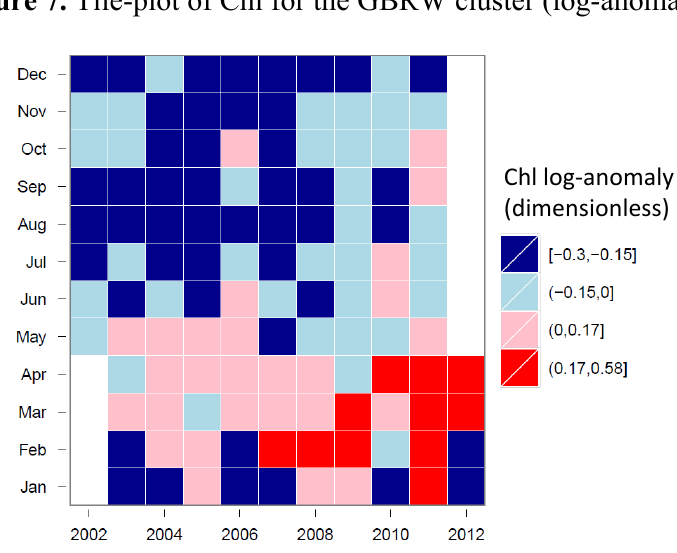
Figure 7. Tile-plot of Chl for the GBRW cluster (log-anomalies).